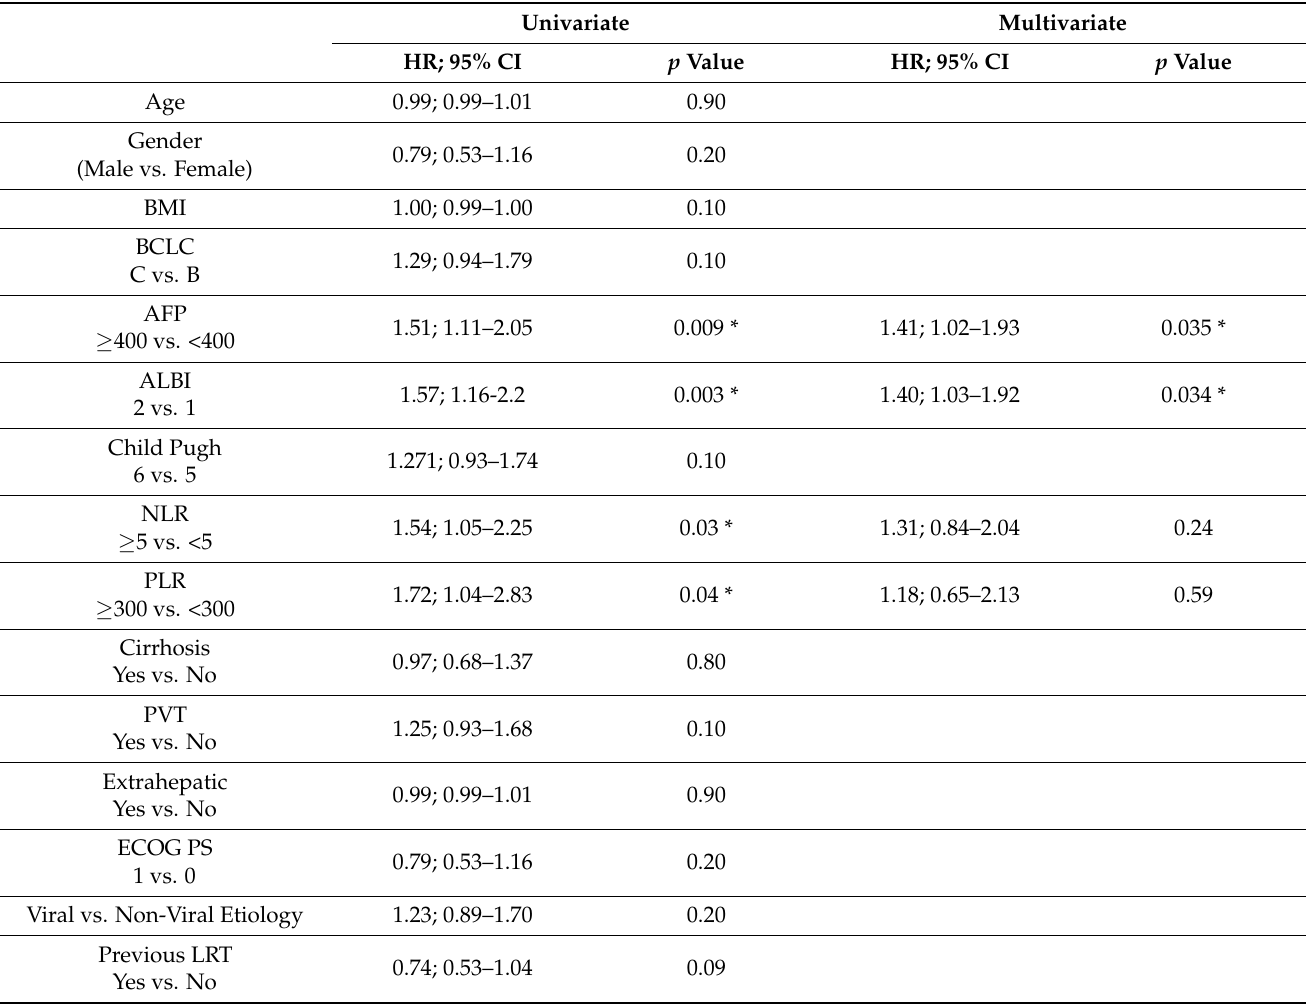
Table 3. Univariate and Multivariate Cox Regression Analyses for Progression-Free Survival. Univariate Multivariate HR; 95% CI p Value HR; 95% CI p